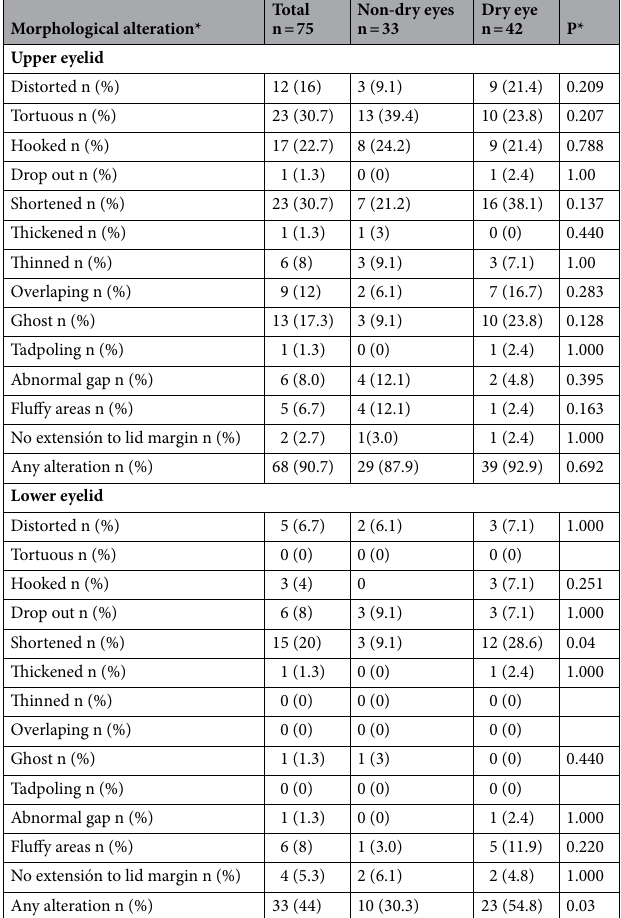
Table 2. Morphological alterations of meibomian glands. *Morphological alteration as defined in Fig.